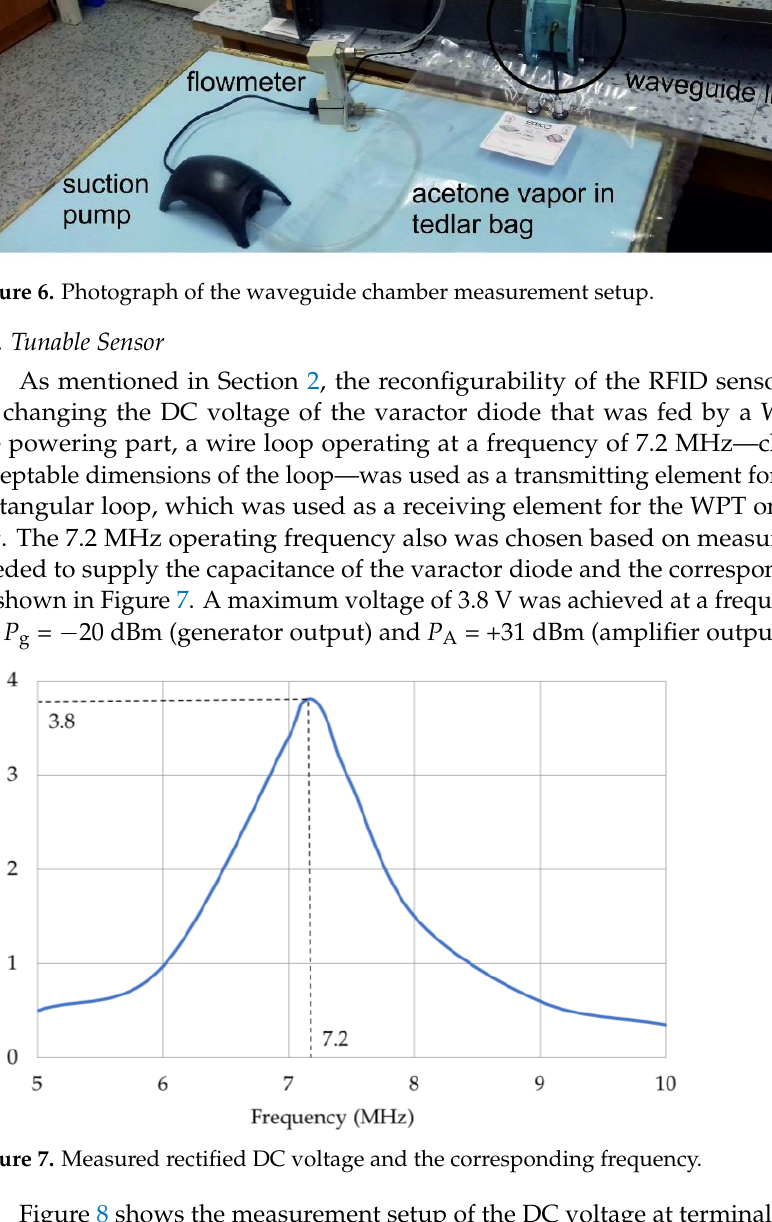
Figure 7. Measured rectified DC voltage and the corresponding